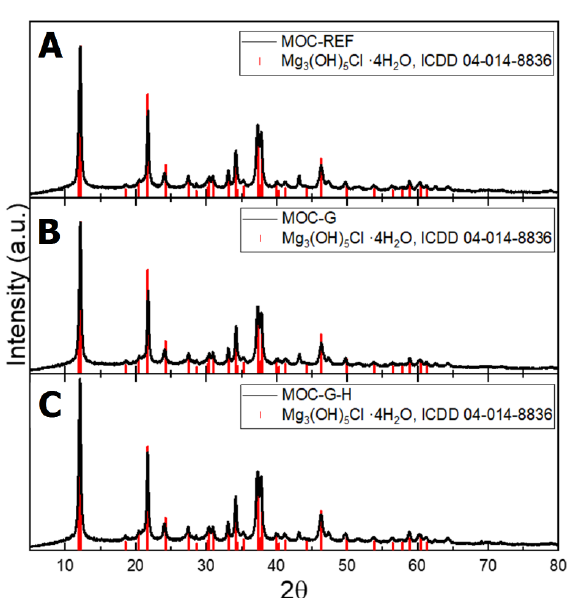
Figure 5. The diffraction patterns of the samples: ( A ) MOC-REF, ( B ) MOC-G, and ( C ) MOC-G-H.